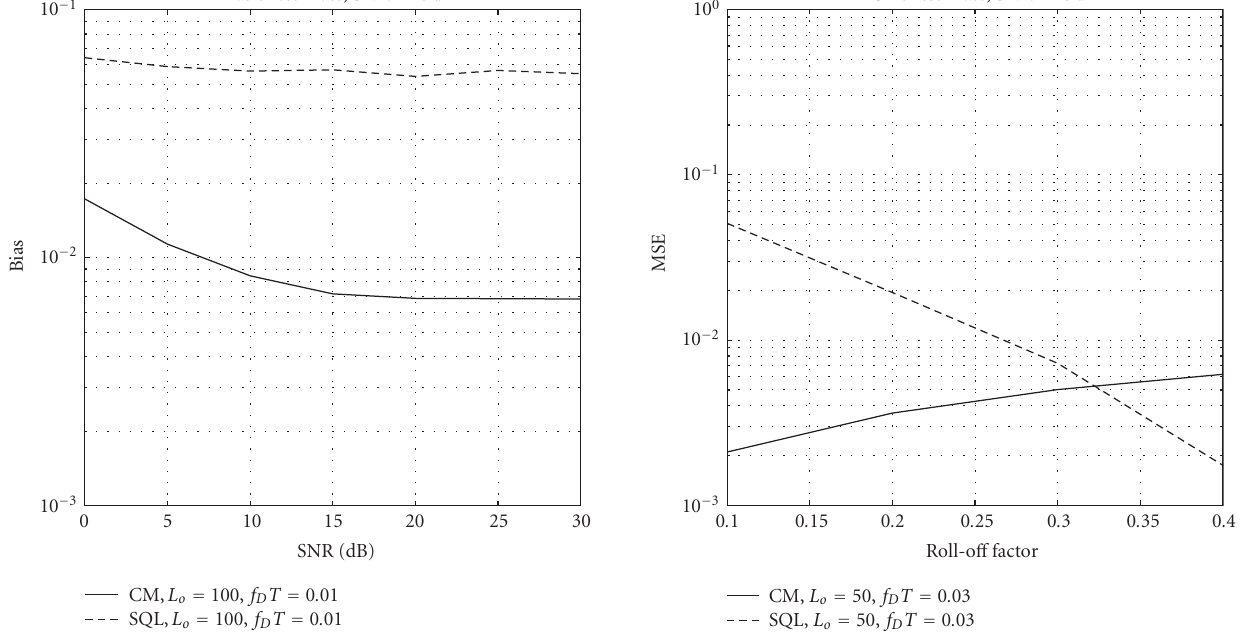
Figure 2: Bias versus SNR of proposed and SQL algorithms. Figure 3: MSE versus roll-o ff factor for proposed and SQL